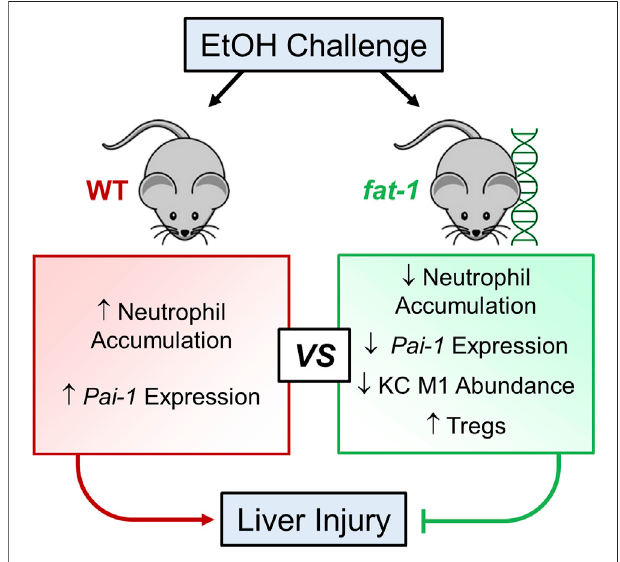
FIGURE 7 | Schematic representation of the bene fi cial effects of n3- PUFA enrichment on liver injury in acute-on-chronic EtOH-induced experimental